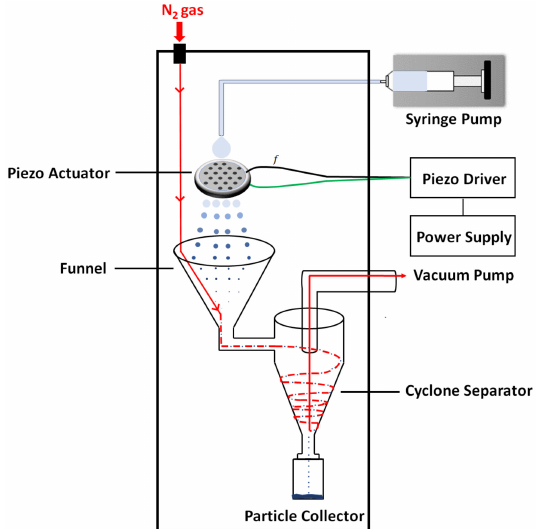
Figure 1. Schematic diagram of our table-top microdevice for the synthesis of inhalable